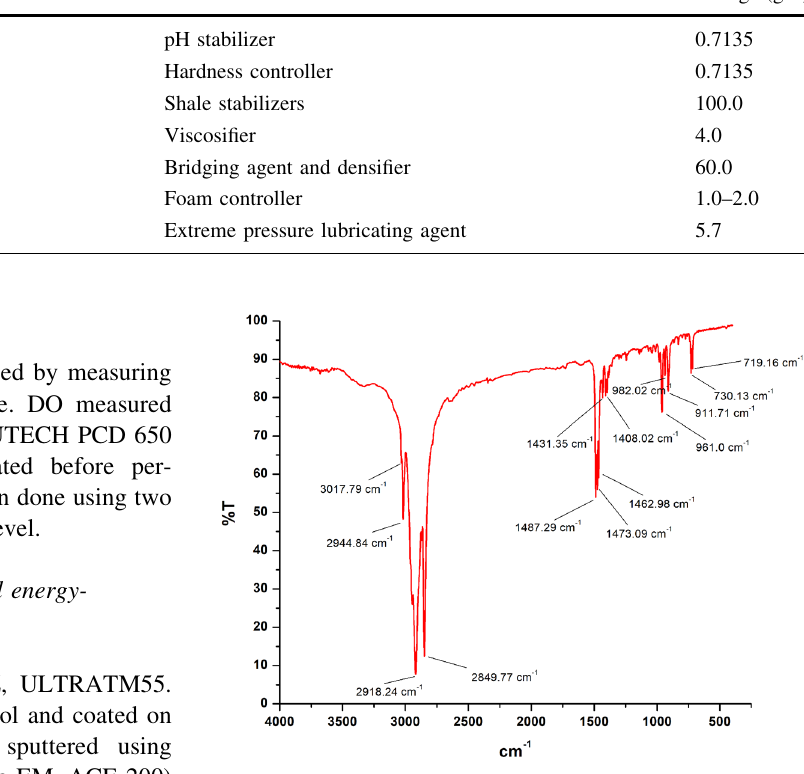
Table 2 Mud additives, functions and dosage of base mud-2 formulation S. no